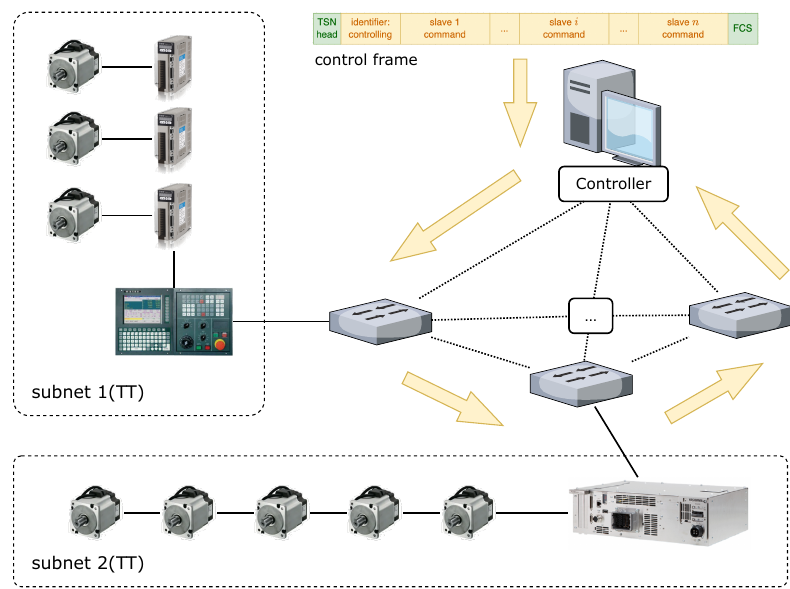
Figure 2. Aggregated forwarding frame-based TT communication.